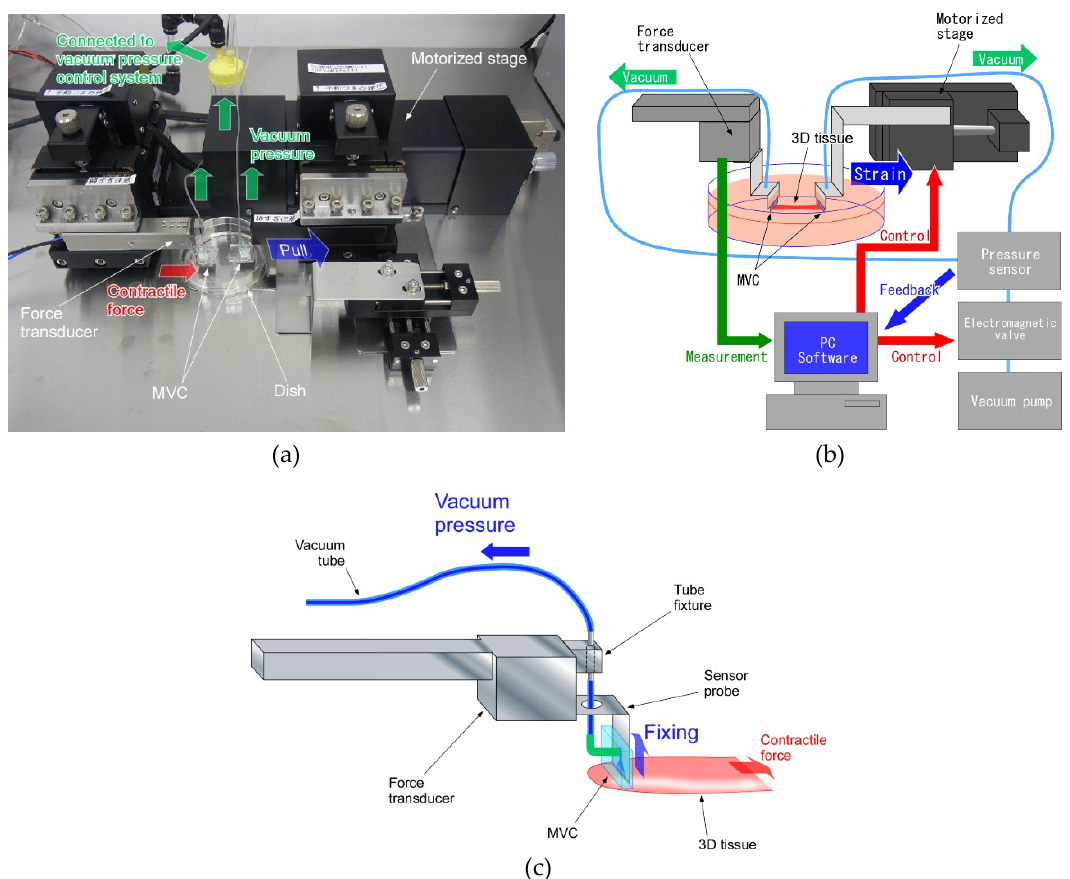
Figure 3. ( a ) Photo of the newly developed tensile test system with attached micro vacuum chuck (MVCs). ( b ) The tensile test system for 3D tissues consisted of six parts. (1) The force transducer was used to measure the bio‐mechanical properties of the 3D tissue. (2) The MVCs fixed the 3D tissue to the force transducer and motorized stage. (3) The vacuum pressure generating system adjusted the vacuum pressure of the MVCs. This vacuum pressure system had a vacuum pump, an electromagnetic valve and a pressure sensor. (4) The motorized stage loaded tensile force onto the 3D tissue. (5) The culture dish protected the 3D tissue from drying out during the tensile test. (6) The charge‐coupled device (CCD) camera and microscope were used in recording the test conditions. ( c ) Schematic illustration around one MVC connected to the force transducer of the tensile test system. The vacuum tube (a flexible silicon tube) was positioned vertically relative to the tensile force loaded direction. A tube fixture kept the tube in place mechanically.